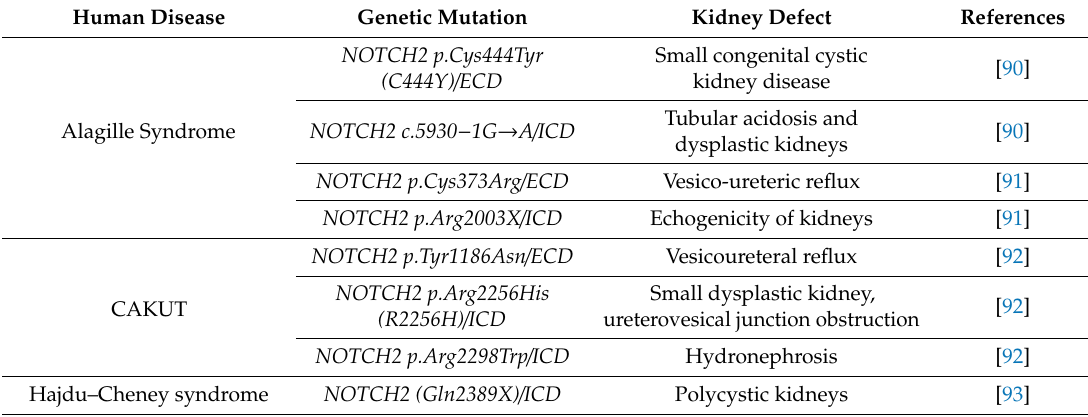
Table 2. Renal anomalies in humans associated with mutations in